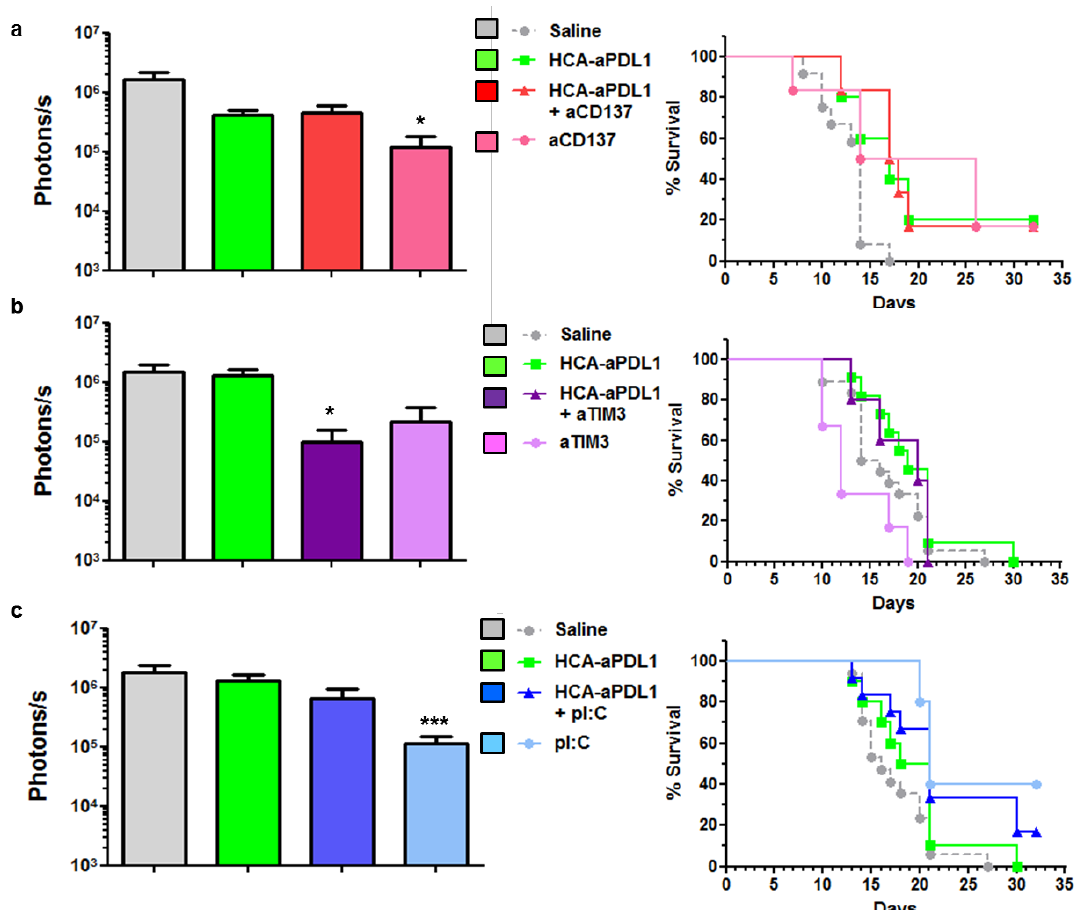
Figure 5. Combination of HCA-EFZP-aPDL1 and aCD137, aTIM-3 or pI:C in the PC model. Tumors were established and treated with HCA-EFZP-aPDL1 as described in Figure 4. ( a ) The aCD137 mAb was administered by i.p. injection on days 0 and 3 at 200 µ g per dose, alone or in combination with the vector ( n = 6). ( b ) The aTIM-3 mAb was administered on days 2 and 5 at 300 µ g per dose ( n = 6). ( c ) pI:C was administered on days 3 and 10 at 50 µ g per dose ( n = 10). The control group ( n = 12) received an i.p. injection of saline solution. The left panels show light emission from tumors at day 7, and right panels are survival curves. * p < 0.05, *** p < 0.001, Kruskal–Wallis test (photons/s) or log-rank test (survival). Data are represented as average ± SEM.